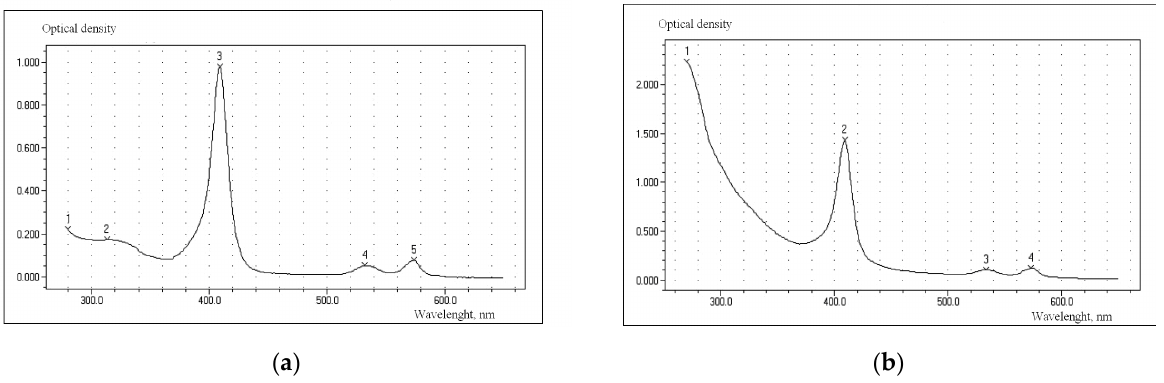
Figure 4. Electronic absorption spectra of pVP from the resins of HO nos. 1 ( а ) and 2 ( b ). Table 6. Vanadium content in PC and pVP from resins.